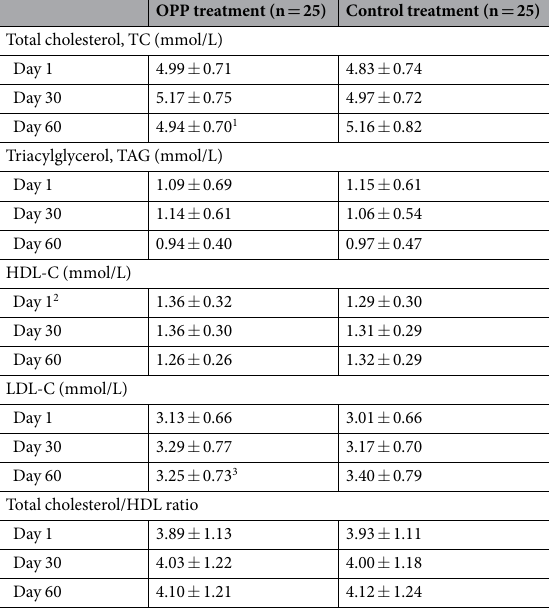
Table 8. Plasma lipid profiles (mean ± SD). 1 Although time × treatment interaction was significant, p = 0.001 (2-factor repeated measures ANOVA) and TC was significantly lower for OPP compared to control treatment (at day 60), based on Wilcoxon signed rank test (p = 0.025), no significant difference of total cholesterol level was found between OPP and control treatments at day 1, 30 and 60 following Bonferroni correction. 2 Baseline HDL-C level was significantly different between treatments, p = 0.038 (Wilcoxon signed rank